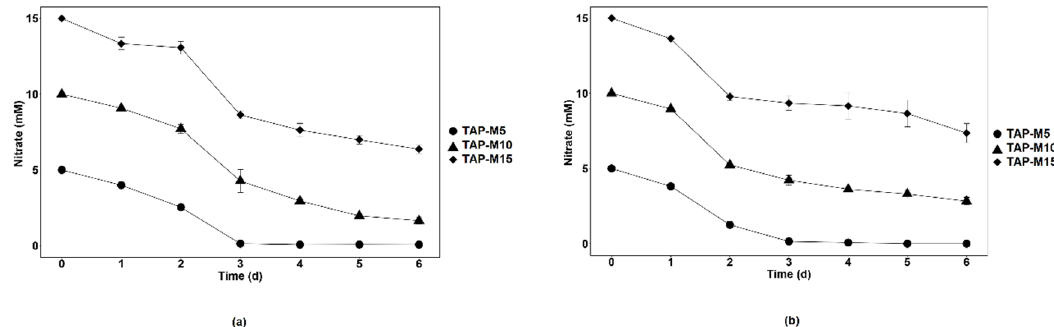
Figure 3. Nitrate removal by Chlamydomonas sp. MACC-216 ( a ) and Chlorella sp. MACC-360 ( b ) from media containing 5 mM (TAP-M5), 10 mM (TAP-M10) and 15 mM (TAP-M15) nitrate. Error bars represent standard deviations. Table 2. Total nitrate removal by Chlamydomonas sp. MACC-216 and Chlorella sp. MACC-360 by 6th day. Values are represented as mean ± standard deviation.